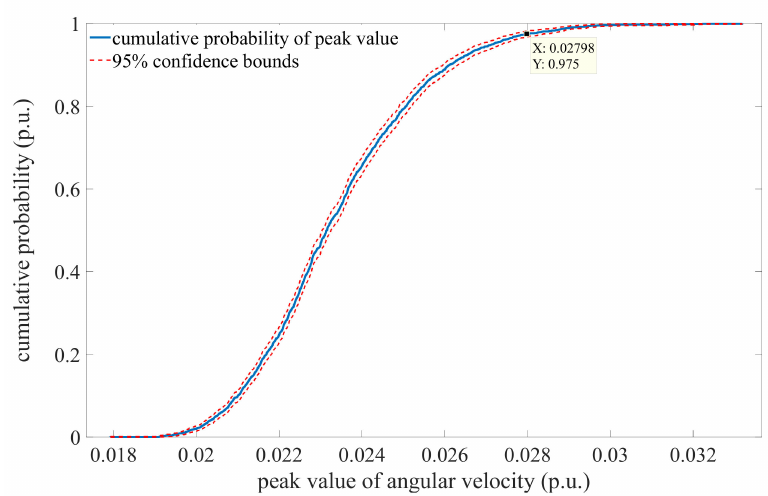
Figure 21. The cumulative probability of the peak value of the angular velocity.